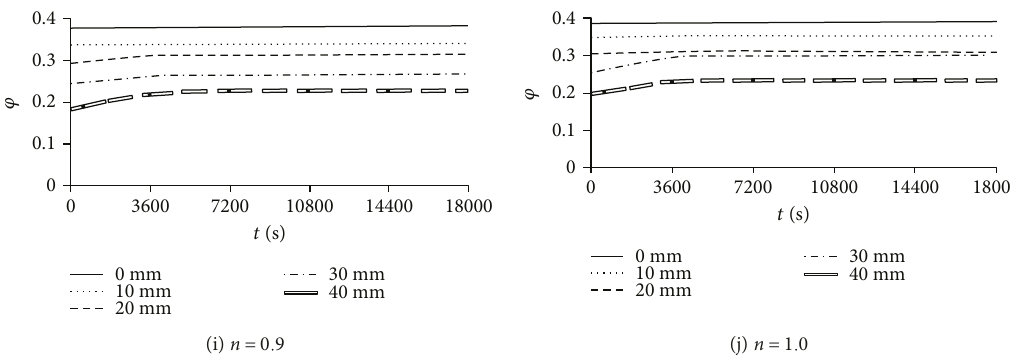
Figure 8: Time-varying characteristics of the porosity in broken mudstone